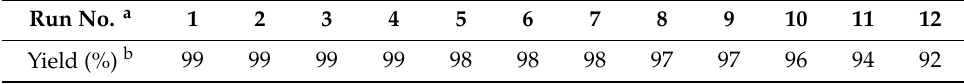
Table 4. Reuses of the supported FeNP catalyst in the reaction of benzaldehyde with